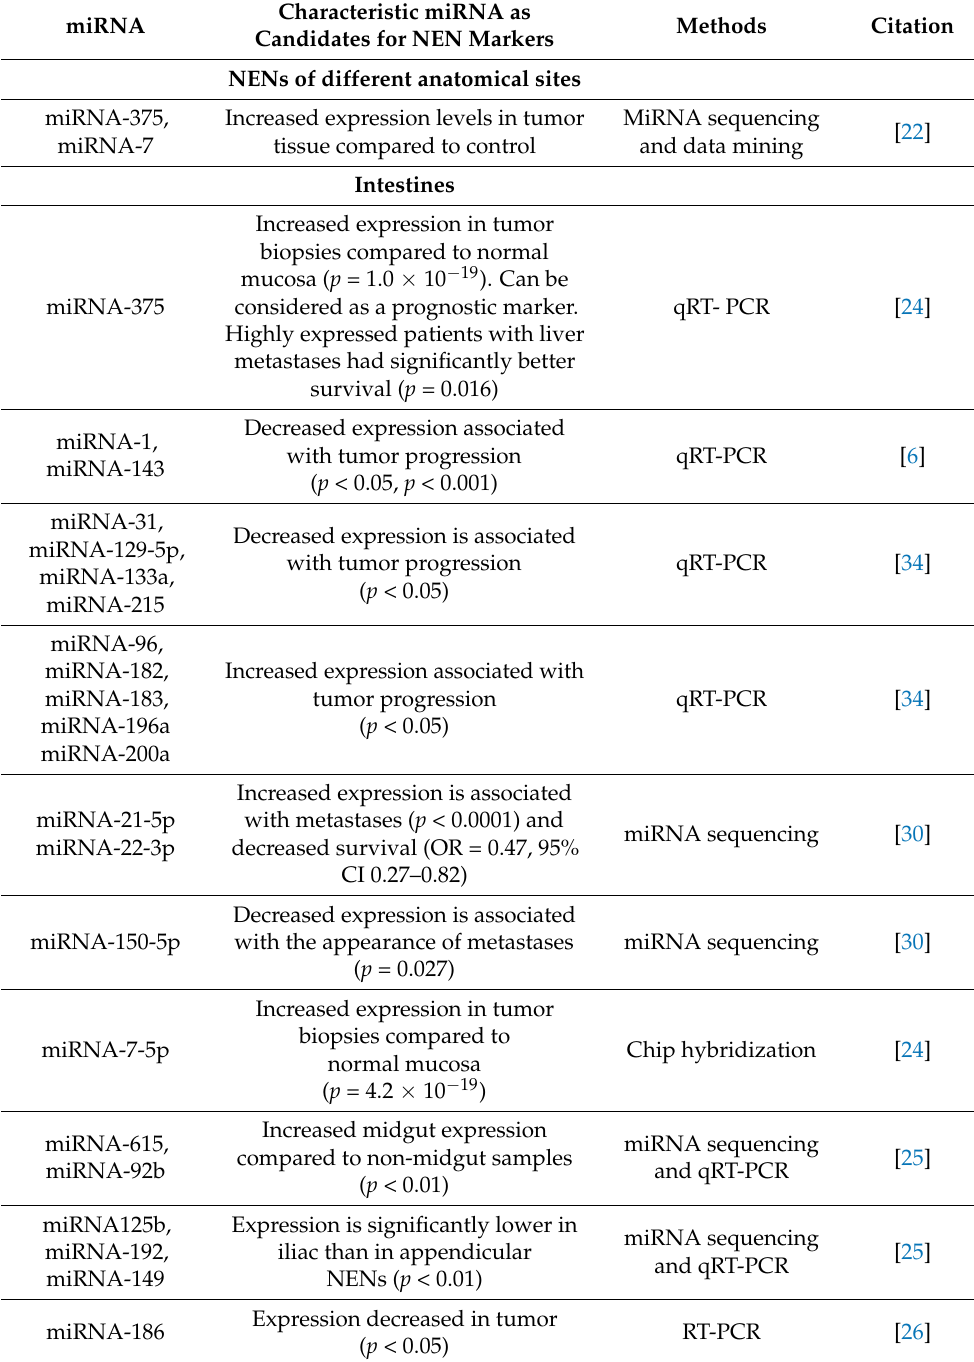
Table 2. MicroRNAs as potential NEN